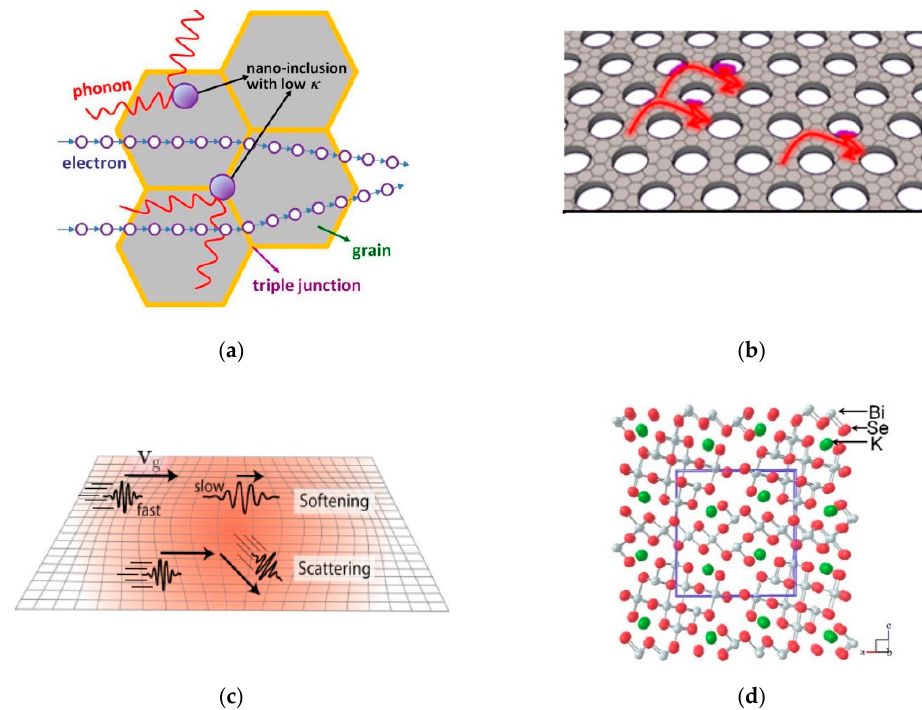
Figure 5. ( a ) Schematic representations of phonon-scattering effects due to nanoinclusion. Reprinted with permission from [96]. ( b ) Schematic representations of transport behaviour of phonons controlled by nanomesh-provided edge scattering. Reprinted with permission from [93]. ( c ) Schematic representations of phonon-scattering and lattice-softening effects due to internal-strain fields. Reprinted with permission from [98]. ( d ) Complex low-symmetry crystal structure of K 2 Bi 8 Se 13 . Reprinted with permission from [104].